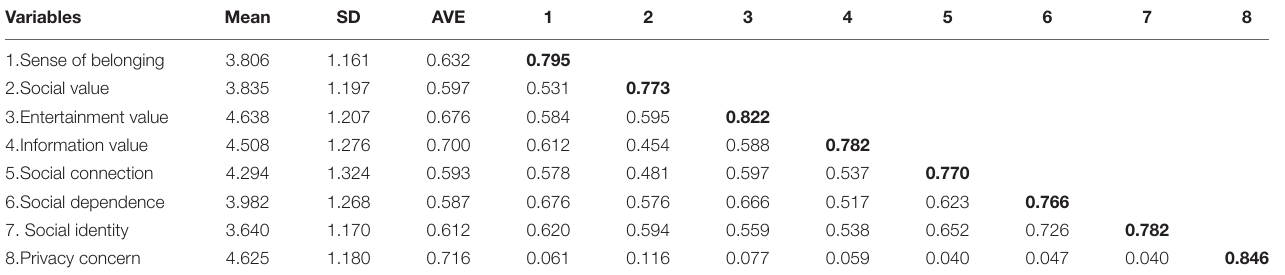
TABLE 7 | Discriminant validity for the measurement model. Variables